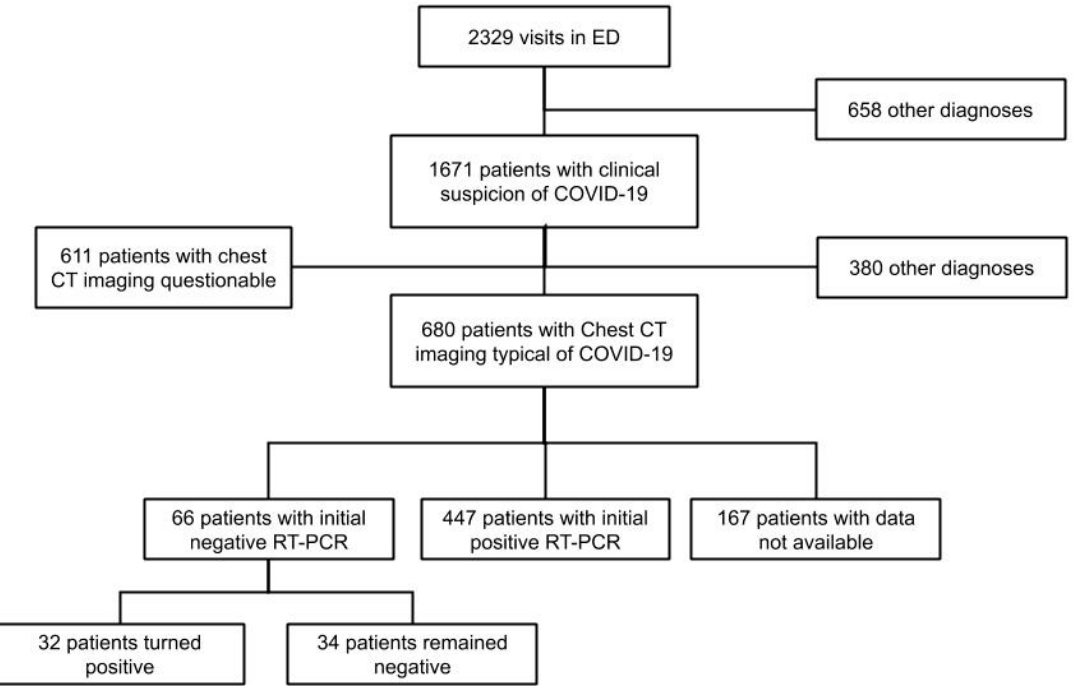
Figure 1. Flow-chart. Abbreviations: ED = emergency department; CT = computed tomography; COVID-19 = Coronavirus Disease 2019, RT-PCR = reverse transcriptase polymerase chain reaction.